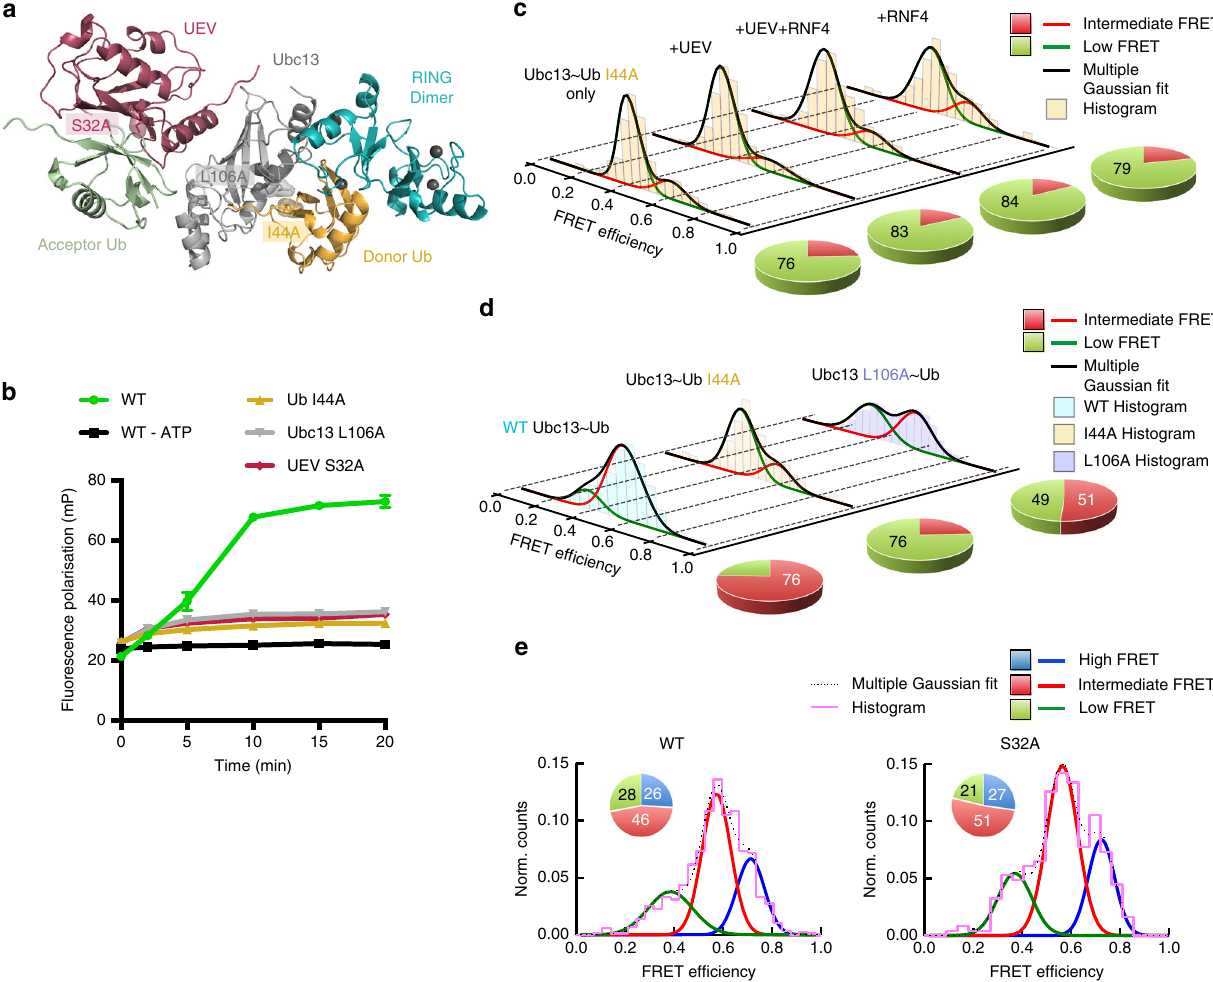
Fig. 3 The role of speci fi c amino acids in the E2~Ub conformation. a Locations of mutations made within the complex (PDB accession number 5AIT). b Fluorescence polarisation ubiquitination assay showing the effect of mutations on K63-linked polyubiquitin chain formation. Data points represent the mean of n = 3 independent experiments and error bars represent ±s.d. Data points are represented for the reaction containing Ub I44A by yellow triangles, Ubc13 L106A by grey inverted triangles and UEV S32A by raspberry diamonds, with a line drawn in the same colour connecting each data point in a reaction. Error bars are omitted when the error is smaller than the data point. c smFRET histograms (yellow) showing the E2~Ub conjugate conformation containing Ub I44A alone and in complex with UEV and the RNF4 RING domain dimer. d smFRET histograms showing the conformation of the WT E2~Ub conjugate (cyan) and the E2~Ub conjugate containing either Ub I44A (yellow) or Ubc13 L106A (purple) at 22 °C. For c , d , pie charts to the right of each histogram highlight the percentage contribution of each FRET state to the overall population. e Normalised smFRET histograms (magenta) showing conformation of the E2~Ub conjugate in complex with the RNF4 RING domain dimer and either WT UEV (left panel) or UEV S32A (right panel) at 22 °C. The multiple Gaussian fi t is represented by a black dotted line. Pie chart insets show the percentage contribution of each FRET state to the overall population. Source data are provided as a Source Data fi